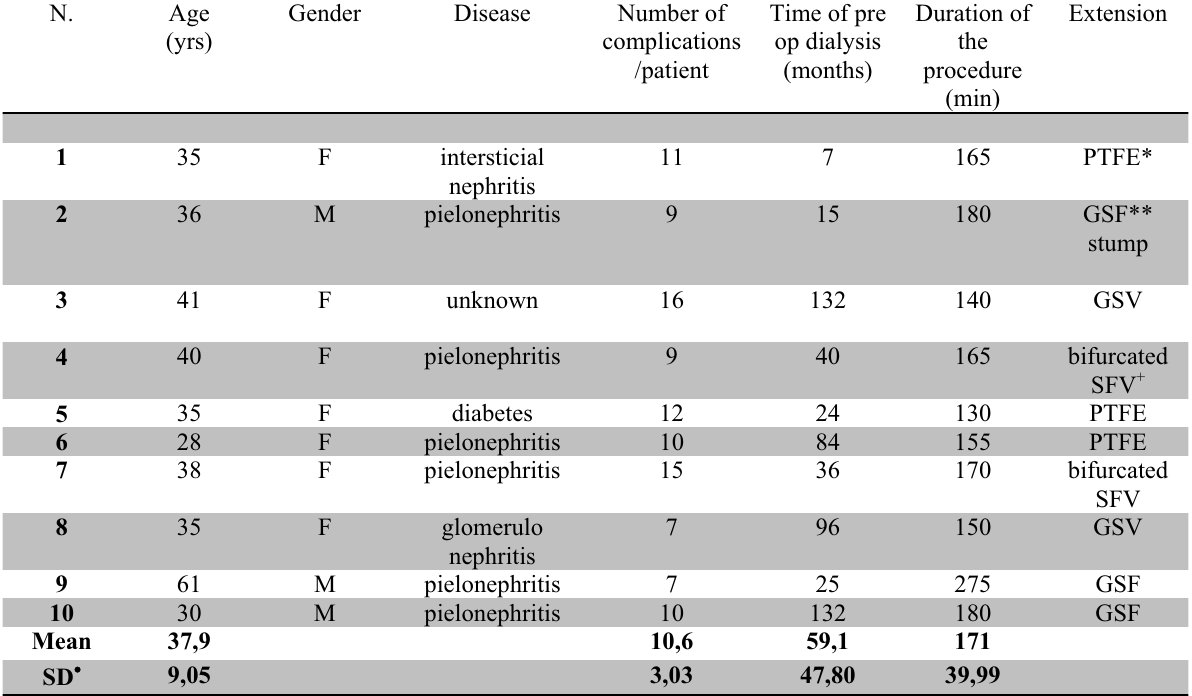
TABLE 1 – General characteristics of the patients (patient number, age, gender, disease, number of complications/patient, time of pre operative of dialysis, duration of the procedure, extension)